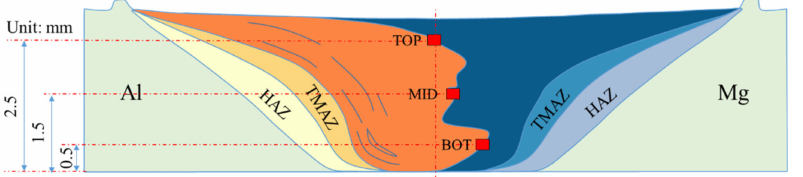
Figure 3. Schematic illustration of weld cross section and SEM characterization locations: TMAZ- thermo-mechanically affected zone, HAZ- heat affected zone. TOP, MID, and BOT represent the top, middle, and bottom regions of the weld,